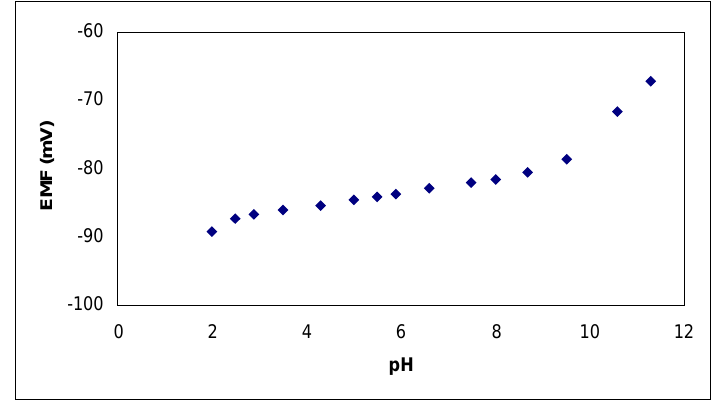
Figure 6. Effect of pH on cell potential.